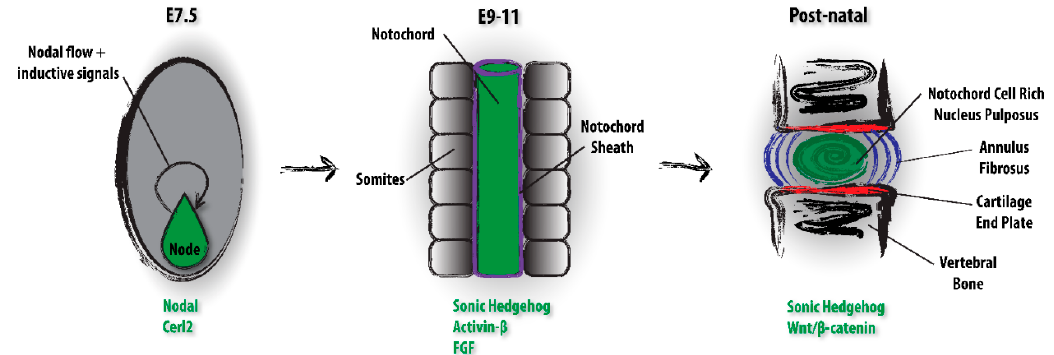
Figure 1. Schematic representation of key events in the transition from notochord to nucleus pulposus development in the murine model. Notochord cells within the mouse embryonic node at embryonic day 7.5 play a fundamental role in left/right patterning of the early embryo by secreting Nodal and Cerl-2. Notochord cells proliferate and migrate to form the embryonic notochord (surrounded by the notochord sheath) between embryonic day 9–11 where they provide instructive cues that pattern the neural tube and sclerotome through secretion of sonic hedgehog. Notochord cells then go on to form the mature nucleus pulposus (NP) in the post-natal intervertebral disc (IVD) (shown here in the sagittal plane), where they continue to secrete inductive factors, including sonic hedgehog and Wnt, which serve to regulate intervertebral disc homeostasis.